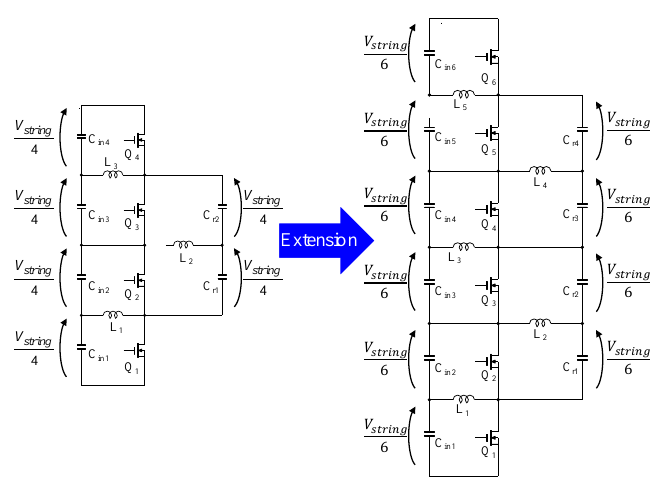
Figure 6. Extension of VD from n = 4 to n = 6.